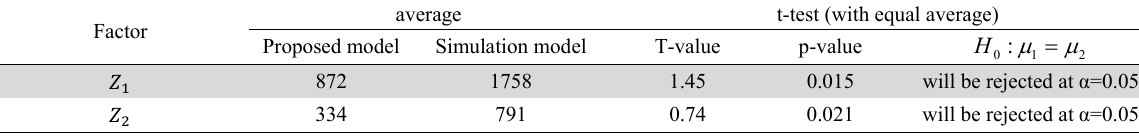
ANOVA for comparing simulation model with proposed model average t-test (with equal average) Factor Proposed model Simulation model T-value p-value